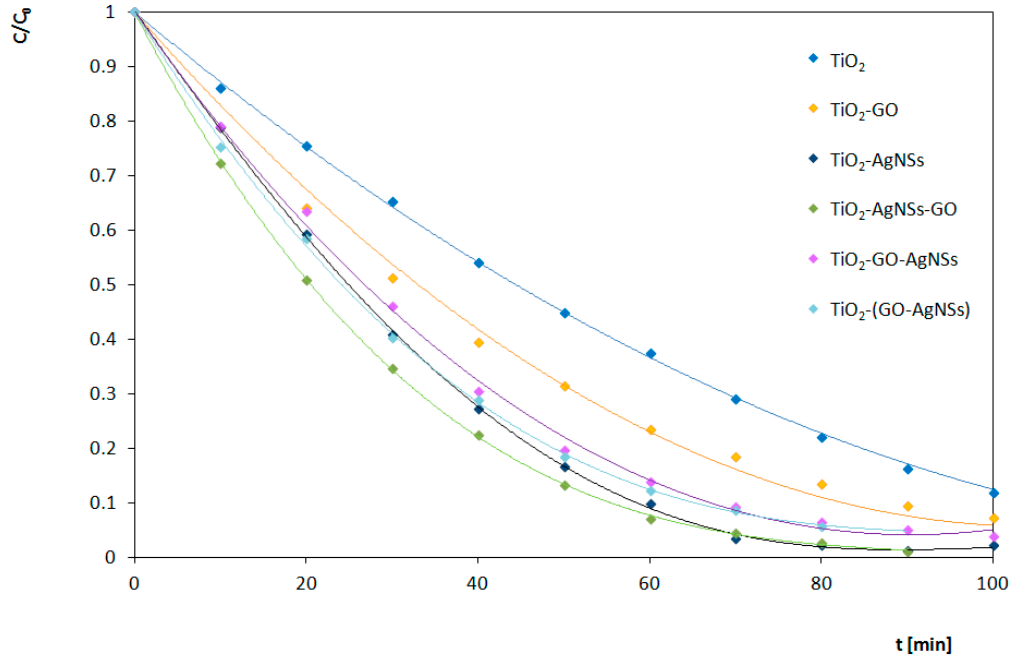
Figure 10. Photocatalytic degradation of RhB under UV irradiation in the presence of prepared